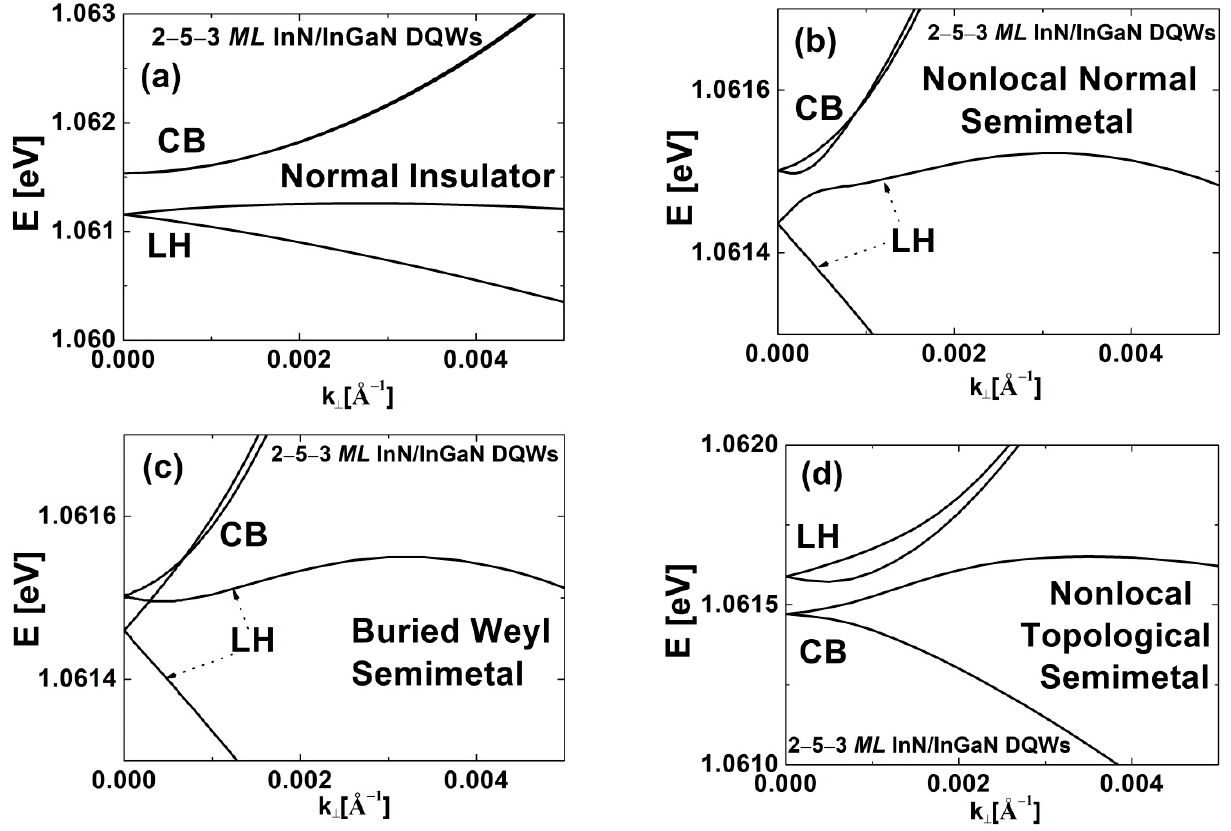
Figure 7. The sub-band dispersions for ( a ) the NI, ( b ) NNSM, ( c ) BWSM, and ( d ) NTSM occurring in InN/In y Ga 1 − y N DQWs with L qw , A = 2 MLs , L qw , B = 3 MLs , and L ib = 5 MLs . The phases appear in order of decreasing In content in the barriers.